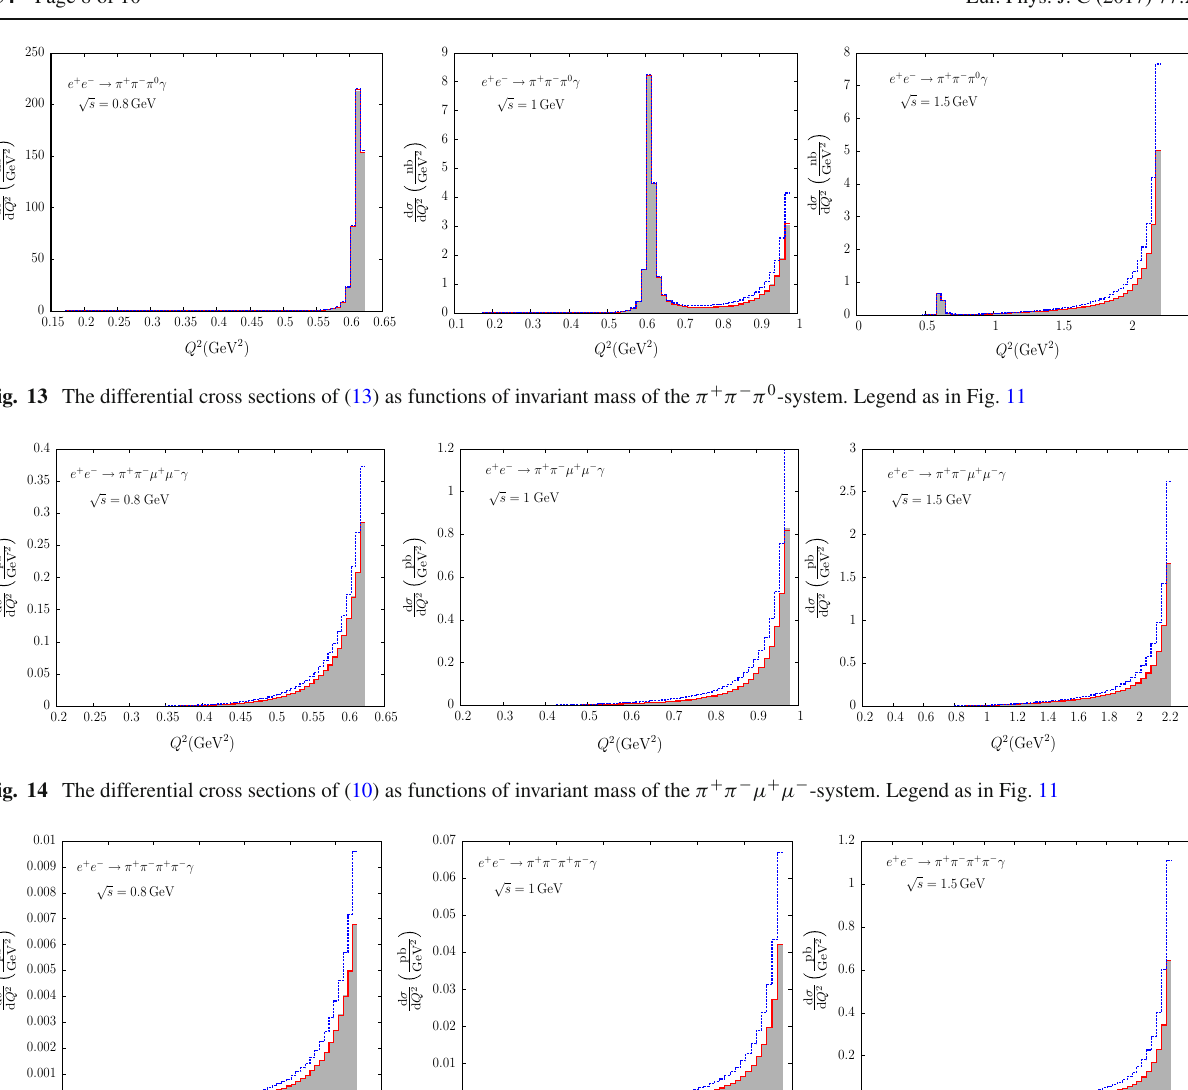
Fig. 15 The differential cross sections of (14) as functions of invariant mass of the π + π − π + π − -system. Legend as in Fig. 11